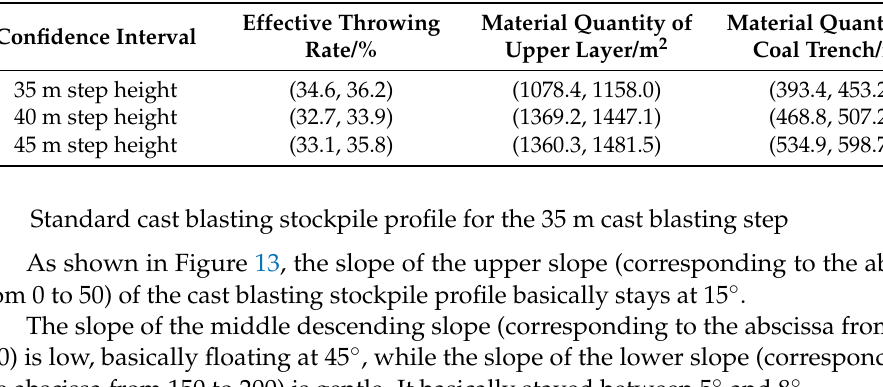
Table 8. Confidence intervals of three basic